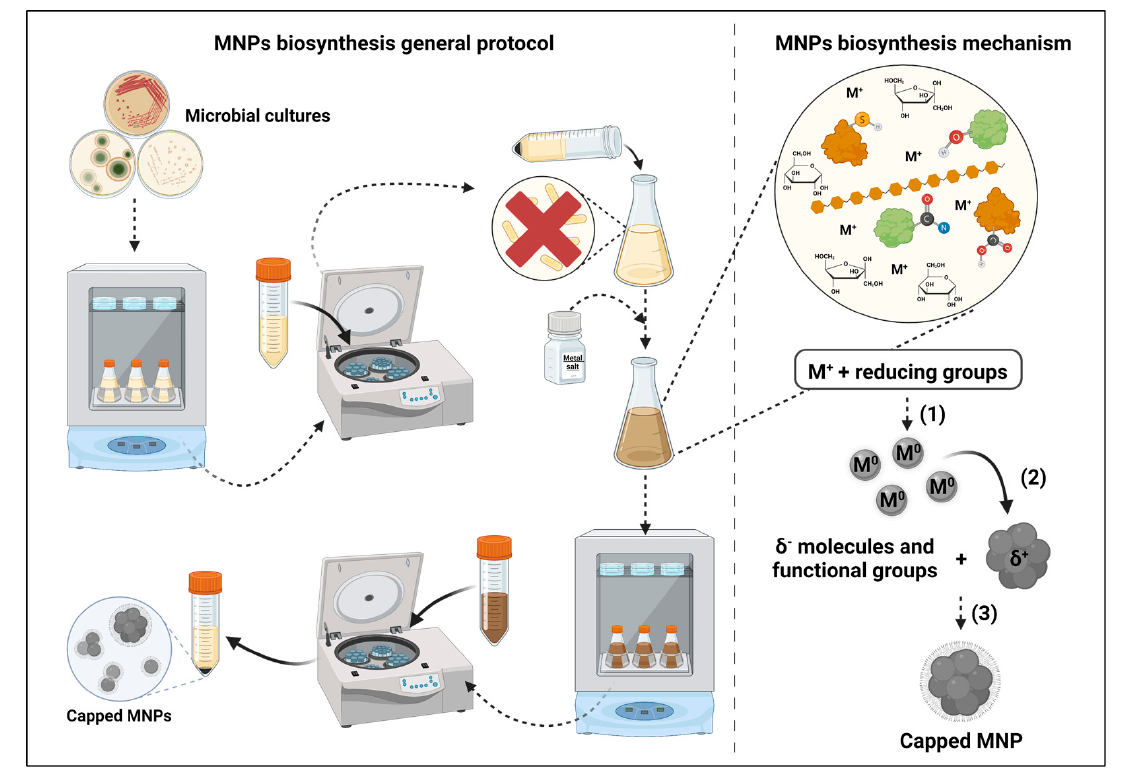
Figure 1. Metal nanoparticles biosynthesis’ mechanisms and general protocol. (1) Metal reduction by enzymes and other molecules from the supernatant; (2) reduced metal particle agglomeration; (3) MNPs capping by negatively charged molecules from the supernatant. Created with BioRender.com.